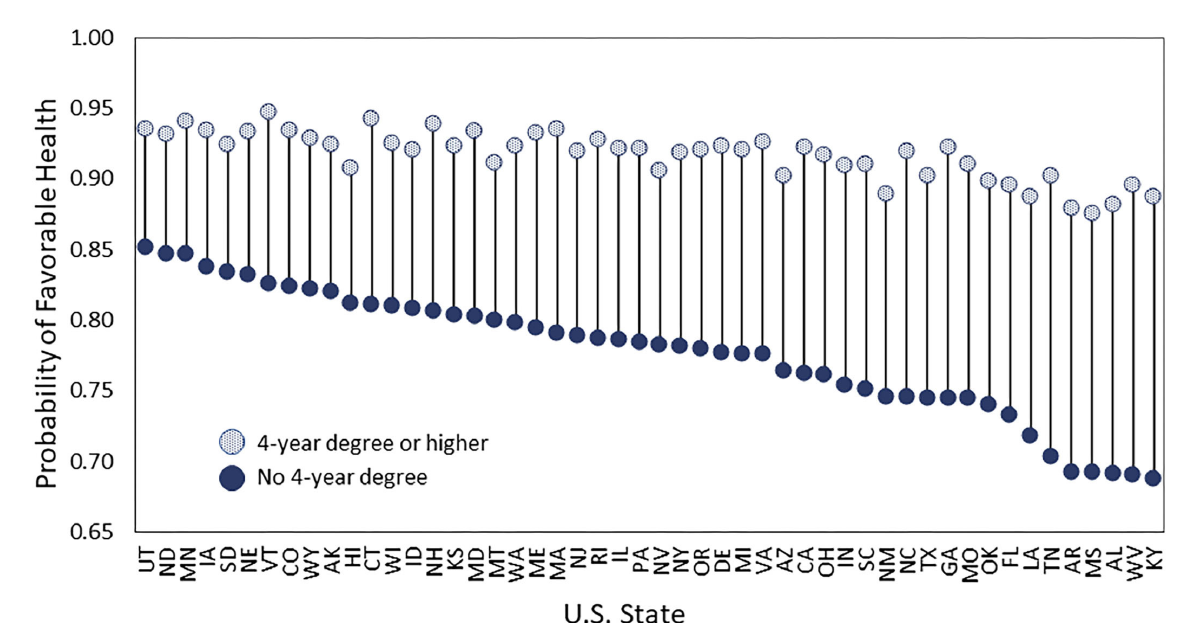
FIGURE1 Probability of reporting favorable health among adults ages 25–64 by U.S. state. Data are from the 2011–2018 BRFSS, include adults ages 25–64, and are adjusted for age, sex, and race-ethnicity differences between states. Adults who reported that their health was excellent, very good, or good are considered in “favorable” health, unlike those who reported that their health was fair or